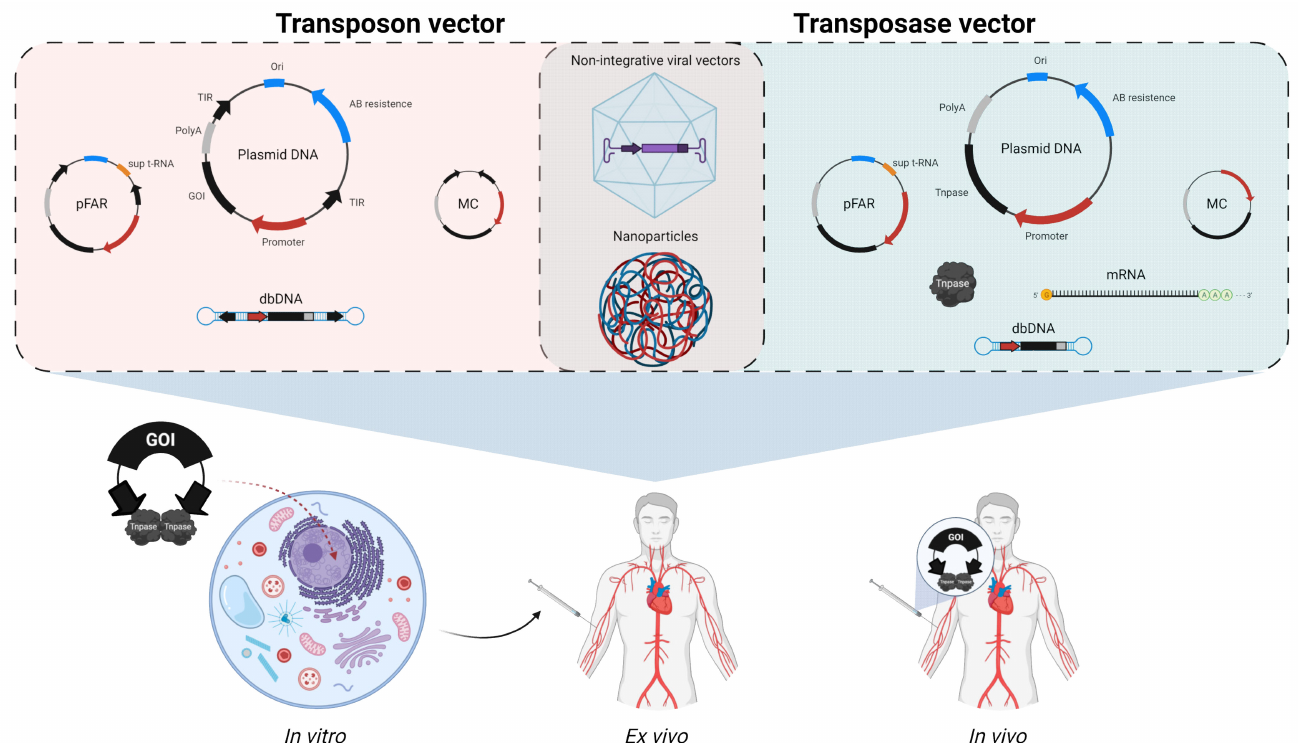
Figure 3. Overview of transposon system delivery methods. The transposon can be delivered as plasmid DNA, plasmid-free of antibiotic resistance markers (pFAR), minicircle (MC), or doggybone DNA (dbDNA) (upper left). The transposase can be delivered as plasmid DNA, pFAR, MC, dbDNA, mRNA, or recombinant protein (upper right). Additionally, hybrid delivery methods combining transposon system components with non-integrative viral vectors or nanoparticles are possible (upper middle). Combined, these delivery methods enable in vitro, ex vivo and in vivo administration